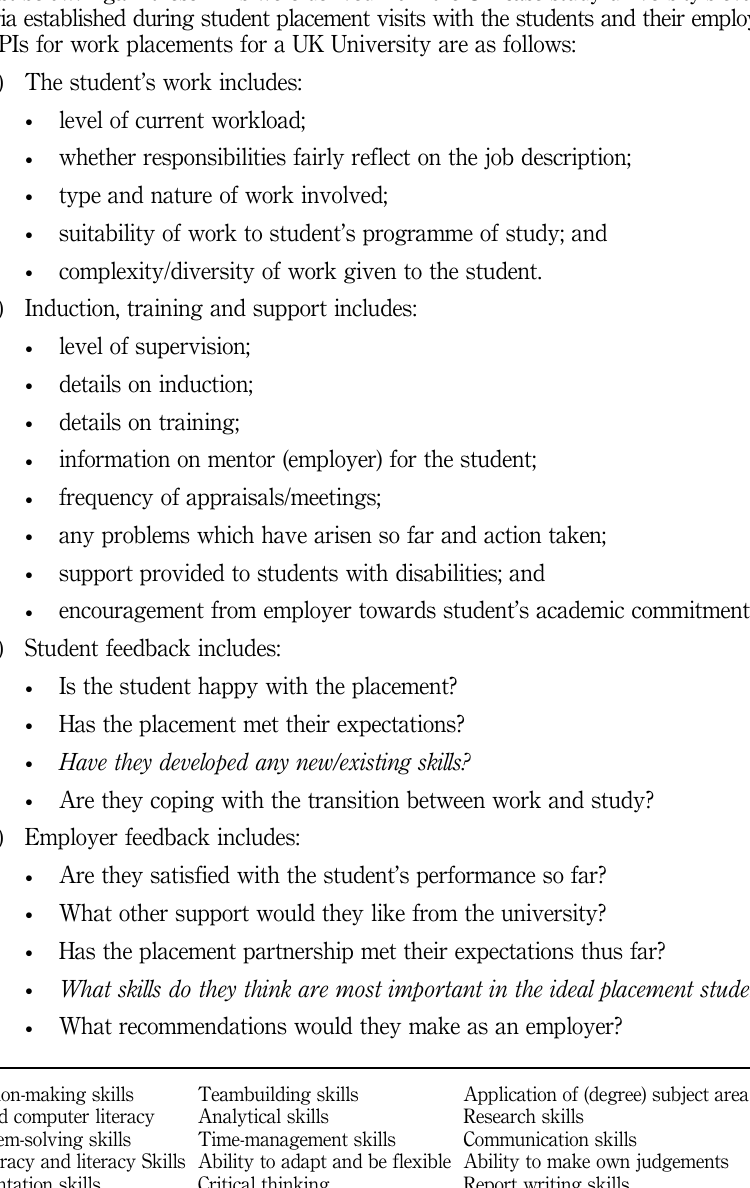
Table I. Envisaged skills gained by placement students according